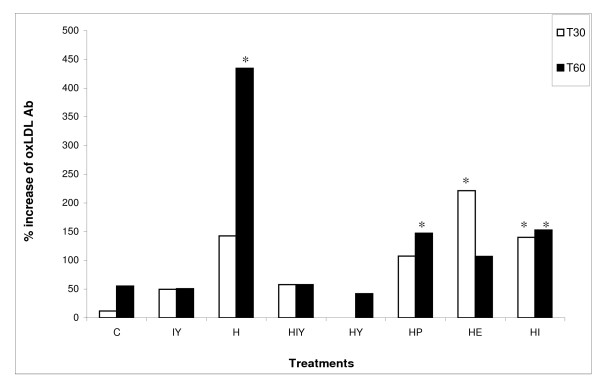
Changes in autoantibodies against oxLDL (percentage) in plasma of rabbits, compared with the baseline levels. Values are means, n = 6. * Significantly different from day 0 (P < 0.05). C = control; IY = isoflavone supplemented soy yogurt; H = hypercholesterolemic; HIY = hypercholesterolemic plus isoflavone-supplemented soy yogurt; HY = hypercholesterolemic plus soy yogurt; HP = hypercholesterolemic plus placebo; HE = hypercholesterolemic plus E.faecium; HI = hypercholesterolemic plus isoflavone.